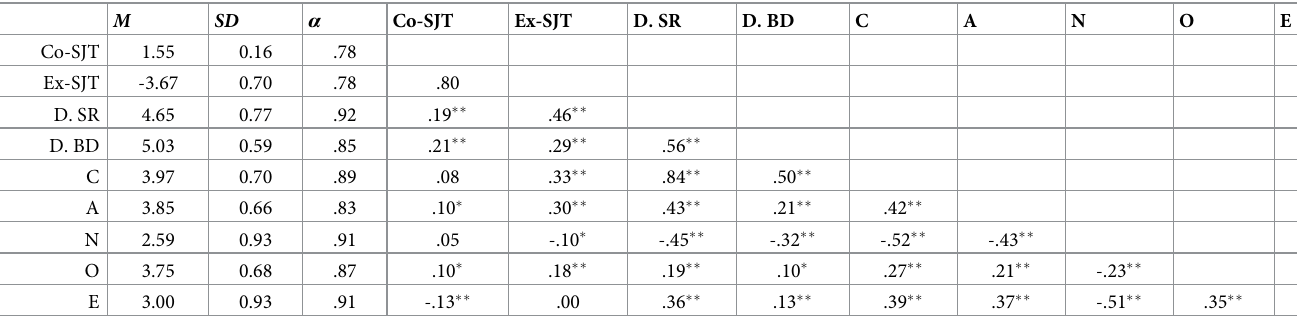
Table 1. Correlations of the dependability scales with self-report measures of